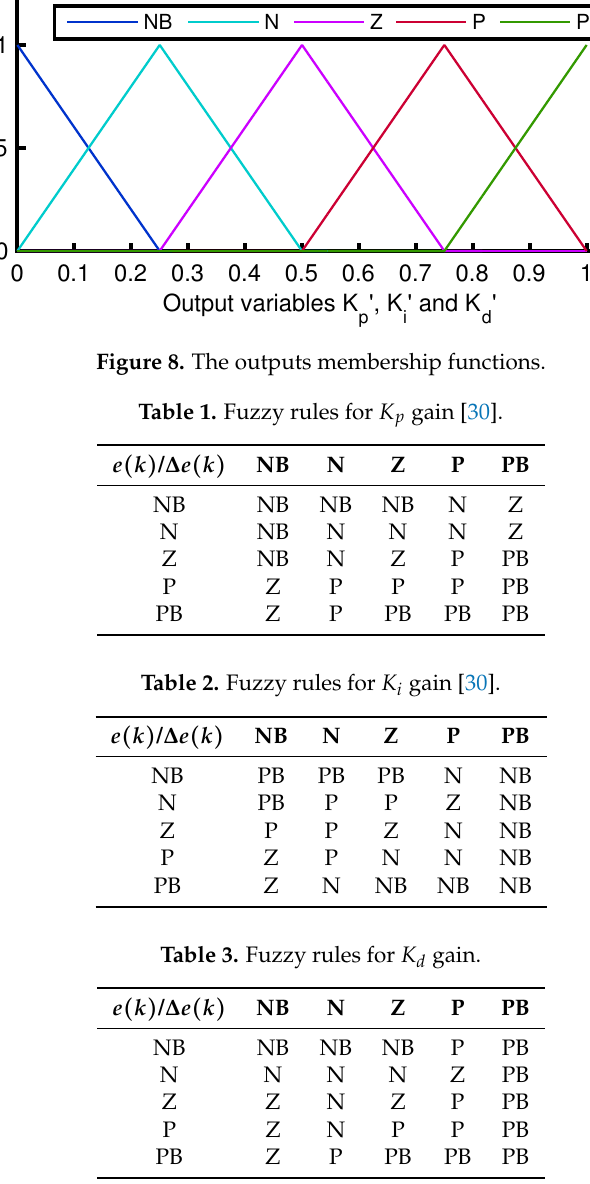
Figure 7. The inputs membership functions. Negative Big (NB), Negative (N), Zero (Z), Positive (P) and Positive Big (PB).